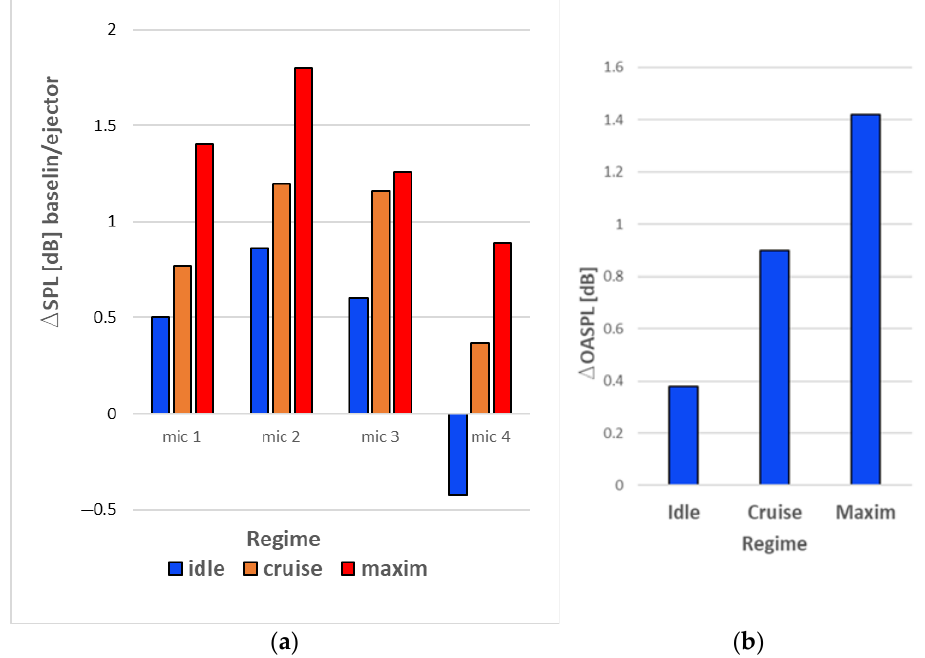
Figure 25. Noise reduction in the ejector nozzle for all the tested regimes by microphone location ( a ) and averaged ( b ).